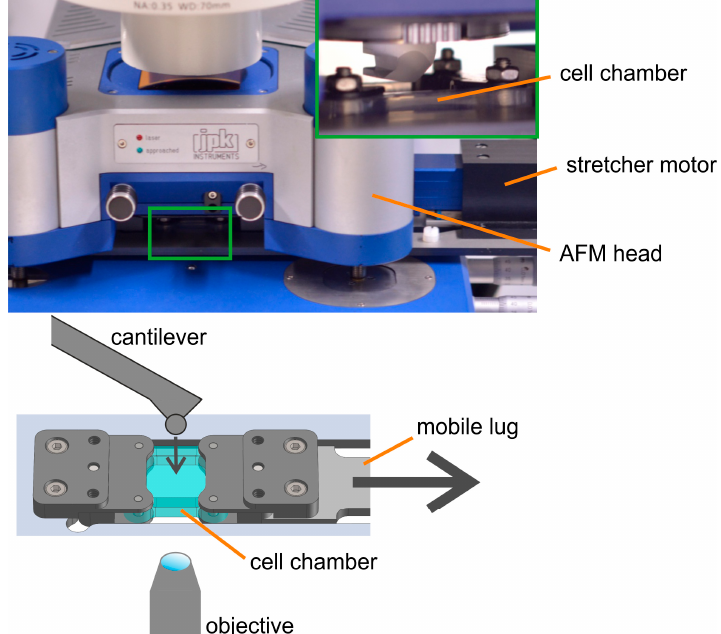
Figure 1. Cells were cultivated in silicone rubber chambers. These were uniaxially stretched by a linear stepper motor connected with a movable lug. Atomic force microscopy (AFM) access is from the top and optical microscopy from the bottom. Photograph of setup ( top ), size 23 cm × 14 cm; zoom-in (green rectangle) size 3.6 cm × 2.3 cm. Sketch of setup ( bottom ) not to scale. Arrows indicate directions of stretch and indentation.